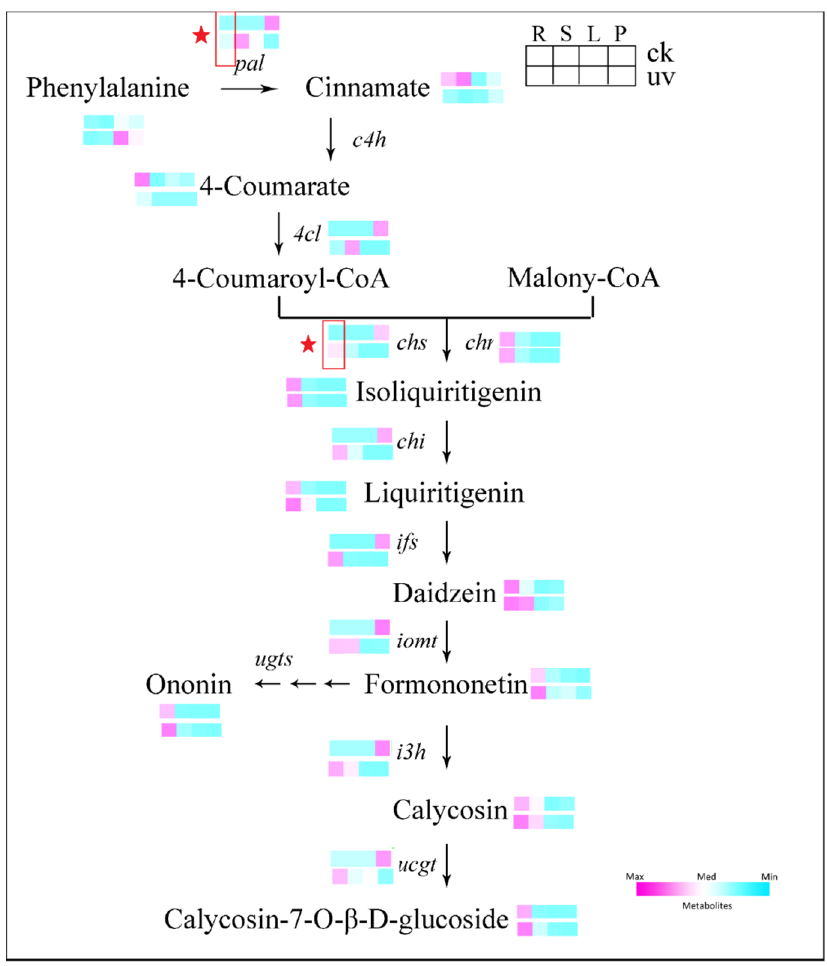
Figure 6. Visualization of isoflavonoid metabolites and relative gene dynamics on a biochemical pathway map. The levels of isoflavonoid metabolites and relative genes were both averaged over three biological replicates after normalization. Within each box, each column is a specific tissue (from left to right: root, R; stem, S; leaf, L; petiole, P), as shown in the upper-right corner. The intensity of the ratio of the UV-B group to the control (CK) group is indicated by the color scale key in the upper-right corner.